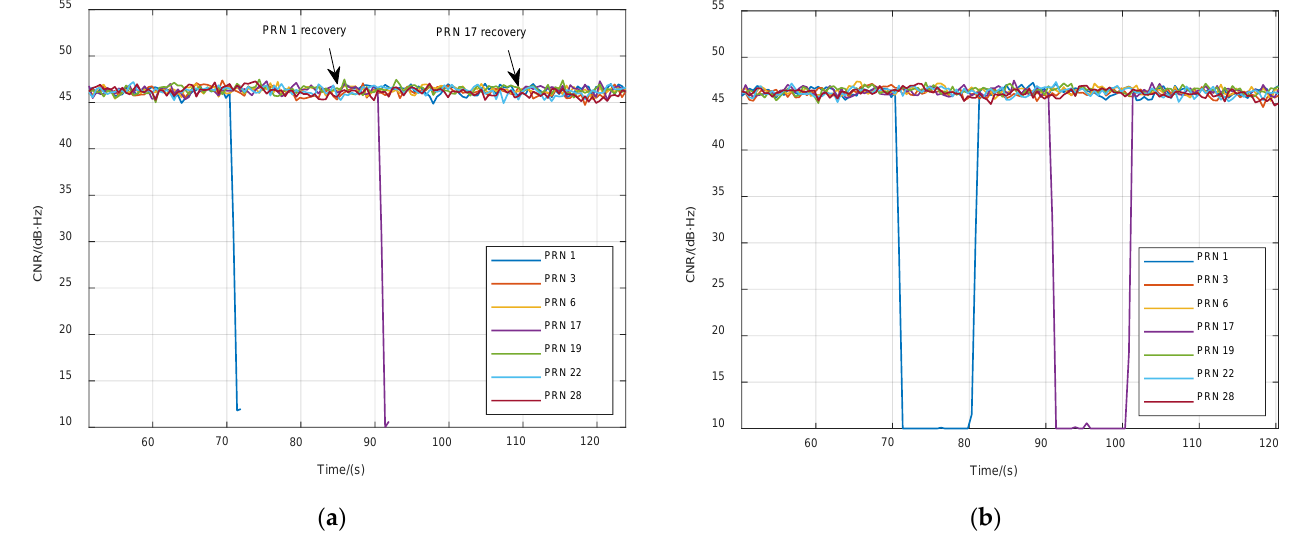
Figure 14. CNR of tracking satellites in case of a partial signal outage. ( a ) STL; ( b ) VTL.